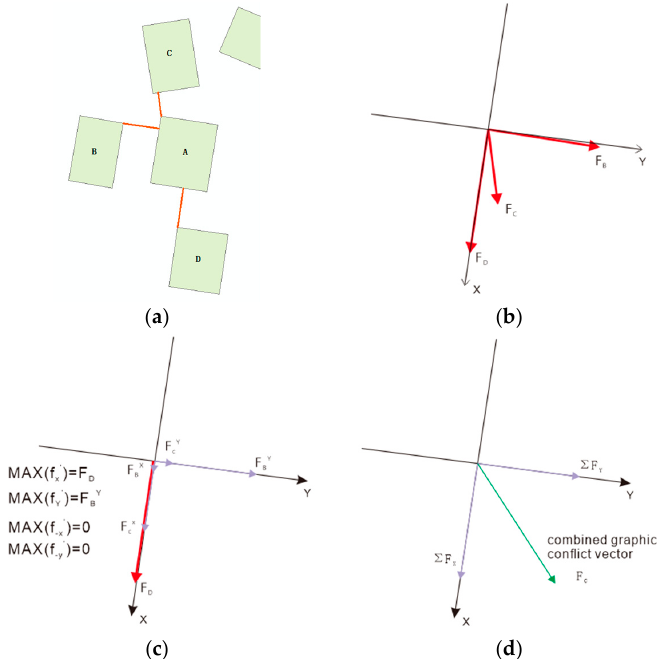
Figure 5. ( a ) The three conflict graphic vectors for building A ; ( b ) Establish a local coordinate system; ( c ) Locate the maximum decomposed vector in the local coordinate system; ( d ) Calculate the synthesis vector.